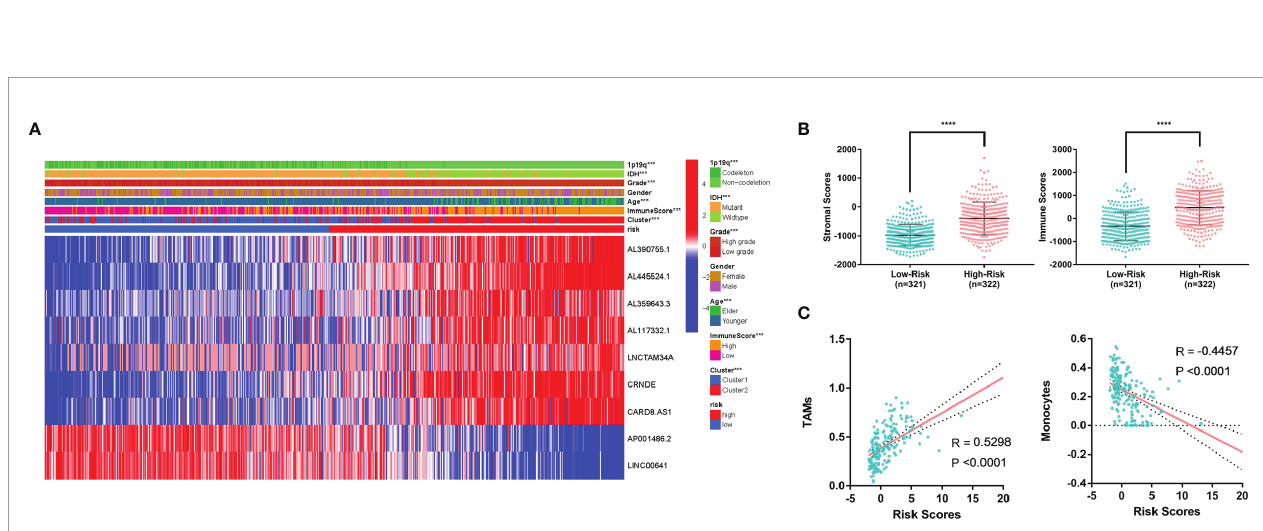
FIGURE 6 | (A) The distributions of risk scores, alive/dead status and the expression of nine m6A-related lncRNAs in the test set. (B) Overall survival analysis for patients in the high- and mid-/low-risk groups. (C) Univariate Cox regression analyses and (D) multivariate Cox regression analyses for OS in glioma patients in the test set. (E) ROC curve of the risk score at different follow-up times. (F) The ROC curve of the risk score and other clinical characteristics.